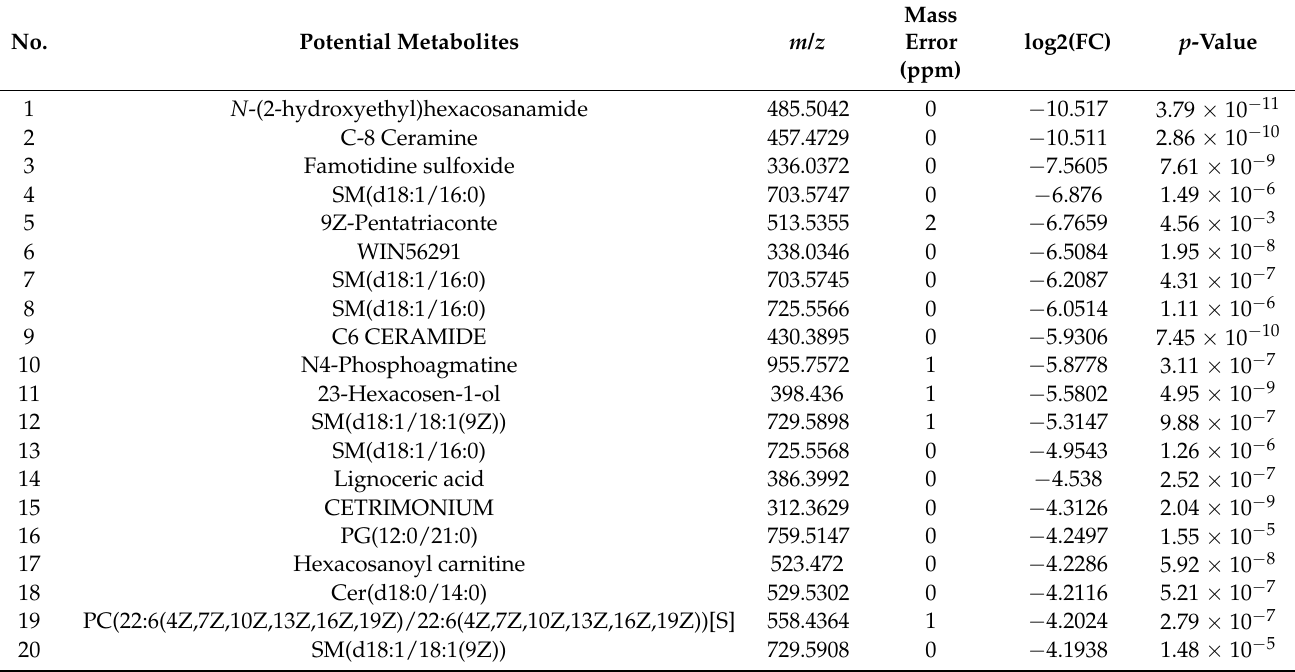
Table 2. Top-twenty down-regulated metabolites of G. duodenalis after treatment with